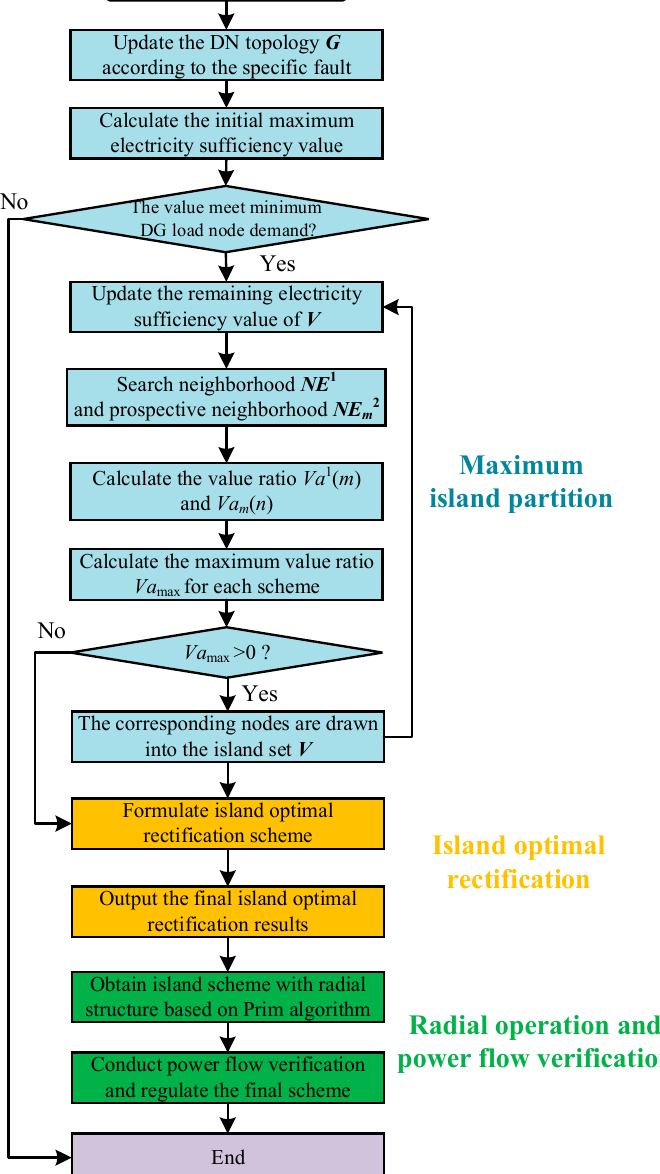
Figure 1. Flow diagram showing island partition.